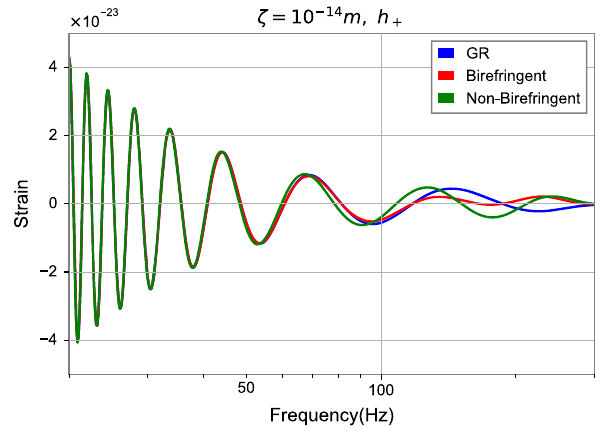
Fig. 1 Birefringent gravitational waveform h + in frequency domain. We let the CPT-violating parameter be ζ = 10 − 14 m. The GR and non- birefringent waveforms are depicted for